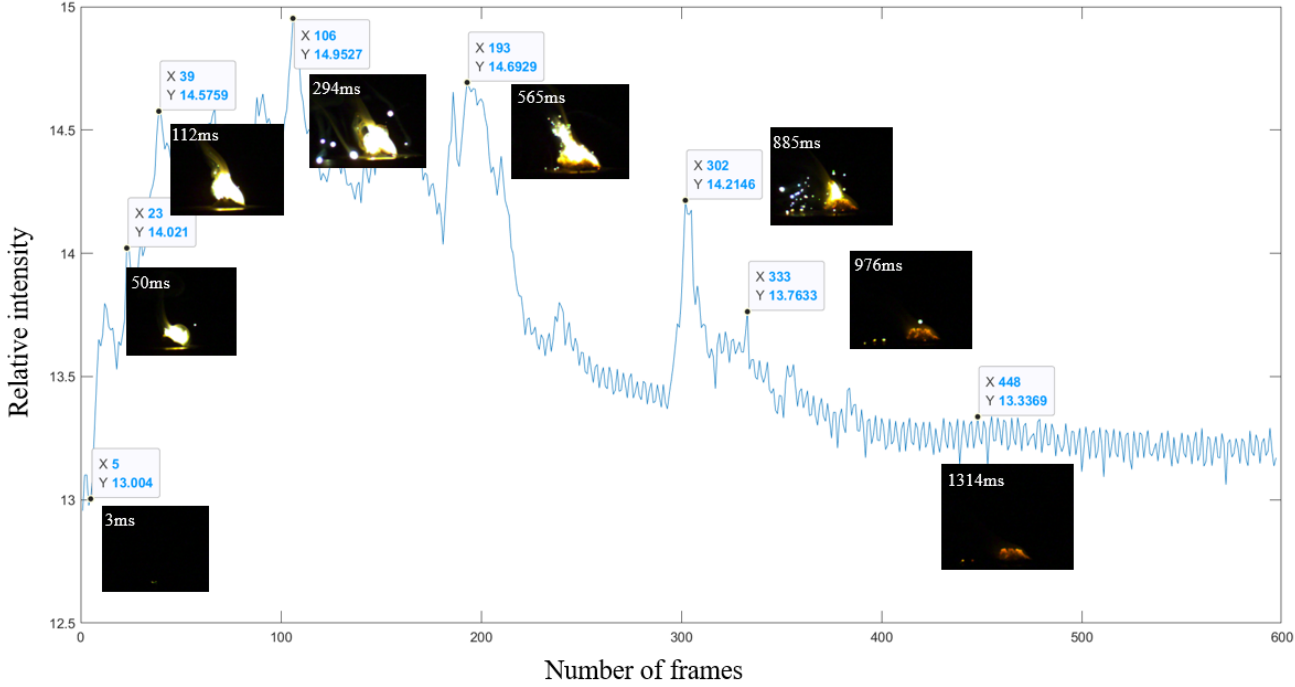
Figure 8. The combustion process of the micro-nano composite aluminum powder.